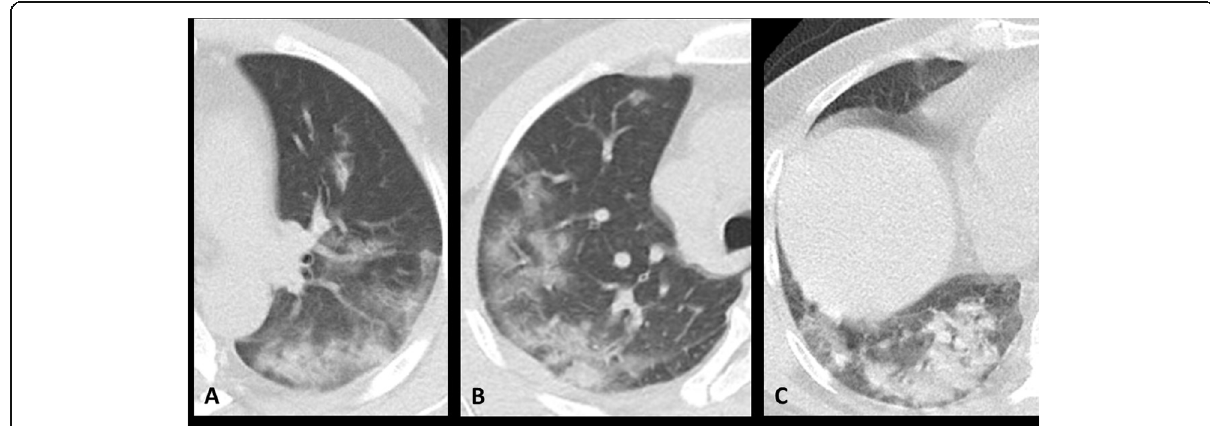
Fig. 5 Peripheral distribution: COVID-19-related pneumonia is presented as peripheral lesions in most of cases. Peripheral distribution is even more encountered in pediatric